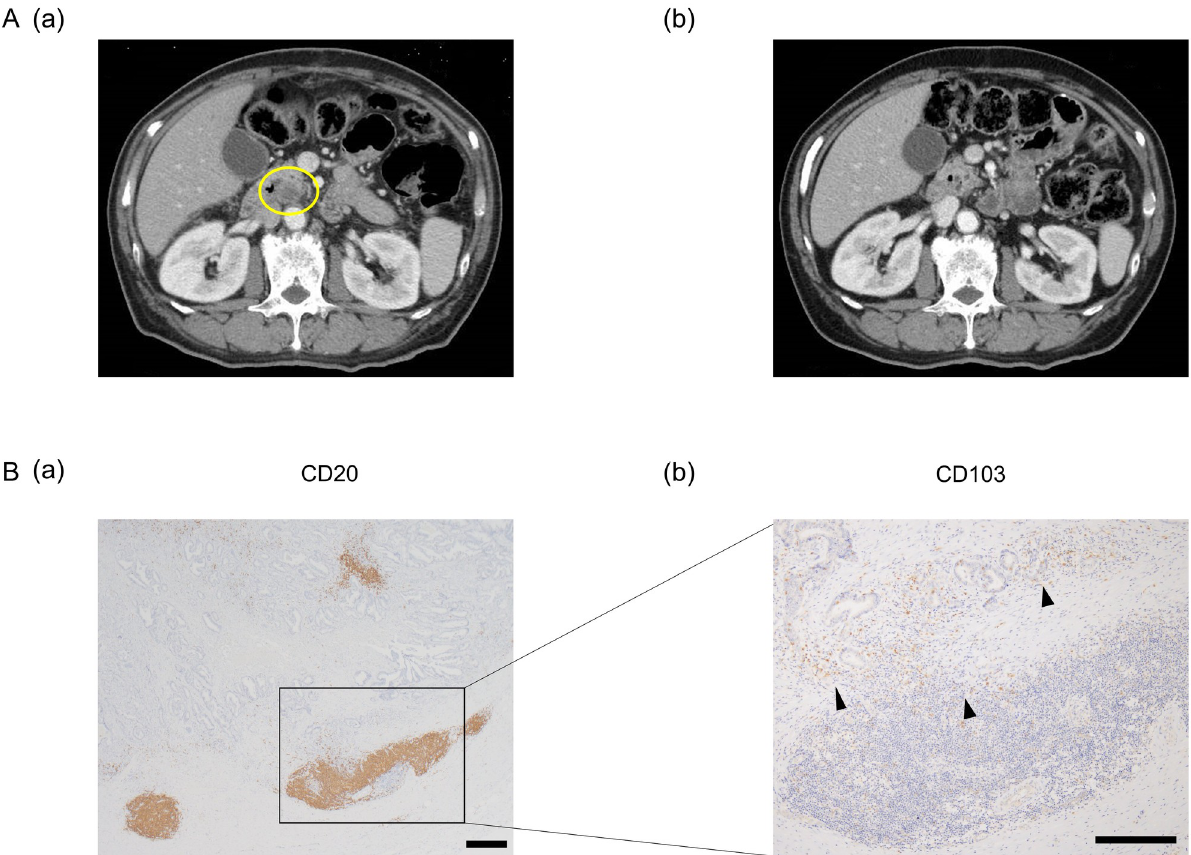
Fig 3. Representative CT-scan images and immunohistochemistry results using anti-CD20 and anti-CD103 antibodies in a PR patient. (A, a) Para-aortic lymph node metastasis recurrence was found (yellow circle). (b) Six months later, the metastatic lymph node decreased. (B, a) Aggregates of CD20 + cells were observed in the tumor tissue, which were considered TLS. Scale bar: 500 μ m. (b) CD103 + T cells were found around TLS (black arrowhead). Scale bar: 500 μ m.